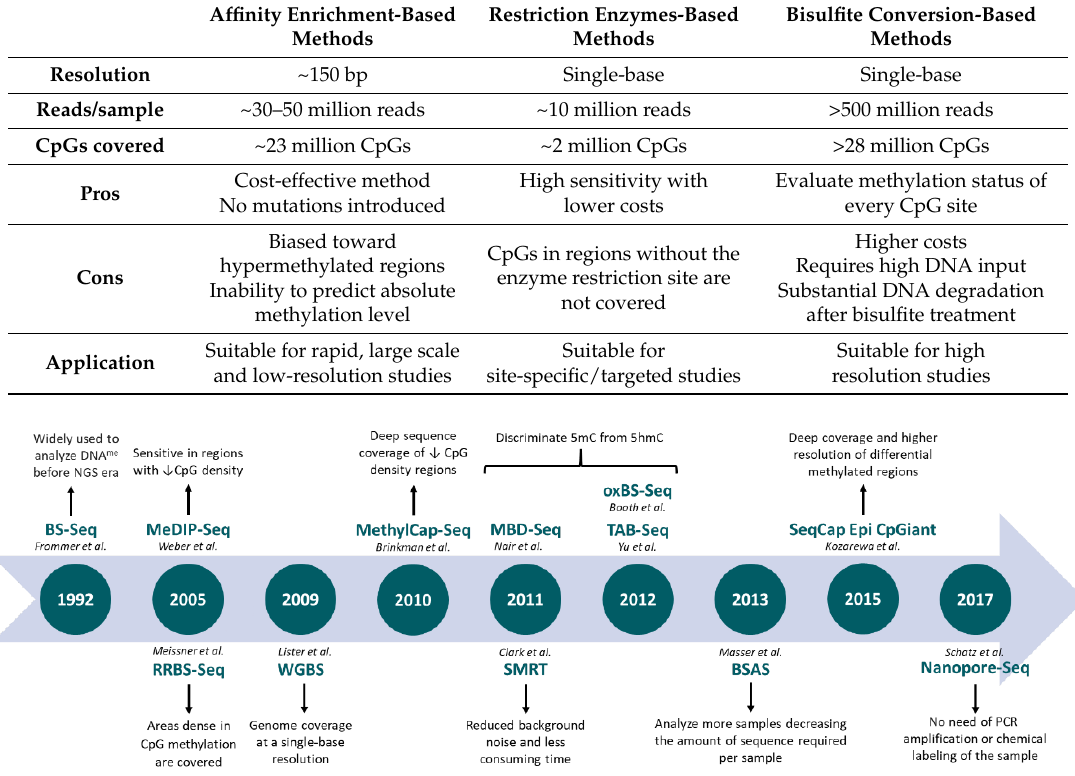
Table 1. Comparison of key features of the different genome-wide approaches for DNA methylation profiling. CpGs: Cytosine-phosphate-Guanine; bp: base pair.